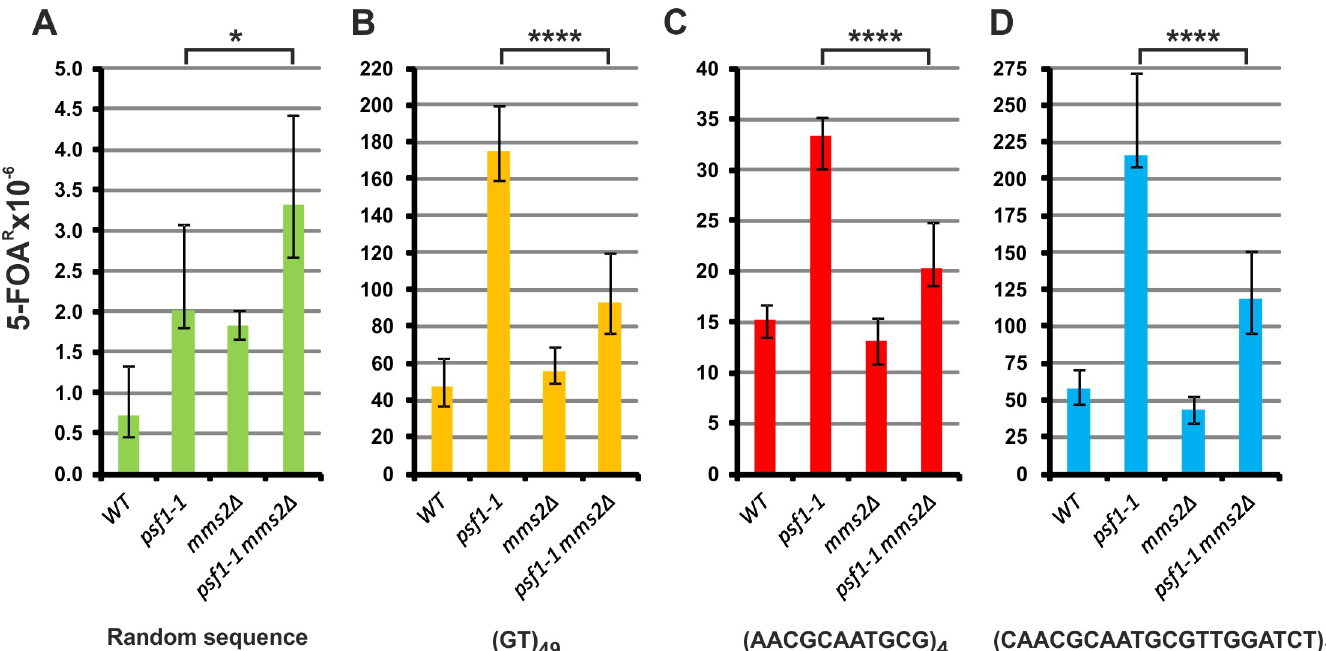
Fig 7. Template switch mechanism contributes to the instability of repeat tracts in psf1-1 cells (A-D). The 5-FOA R mutation rates were determined at 23˚C for yeast cells with the indicated genotypes carrying plasmids with the analyzed sequences; the values are medians with 95% confidence intervals calculated from data for at least ten cultures of each strain; the p values for psf1-1 mms2 Δ versus psf1-1 strains were calculated using the nonparametric Mann-Whitney U statistical test ( � p � 0.05; ���� p � 0.0001). All associated p -values are presented in the S1 Table.